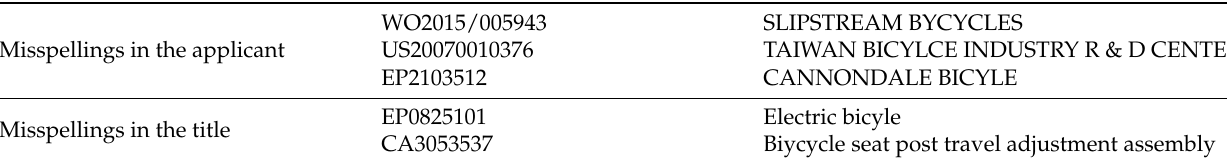
Table 7. Misspellings of bicycle in applicant and